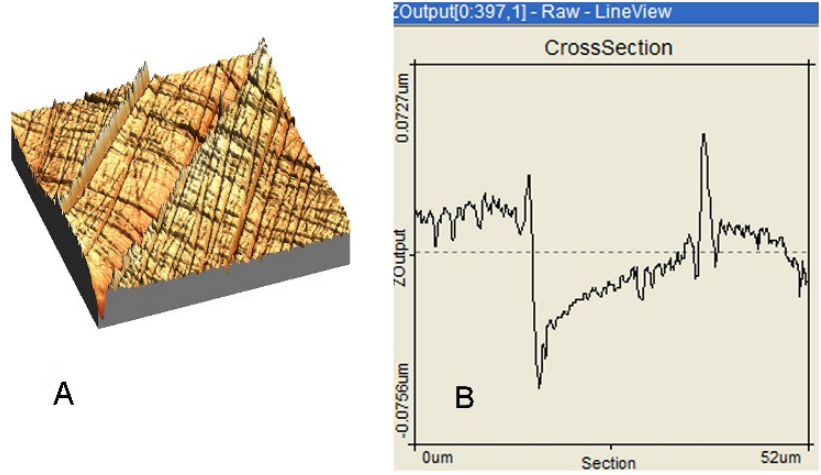
Figure 8. AFM map ( A ) and profile ( B ) of a channel waveguide implanted through a silicon mask using 1.5 MeV N + ions.